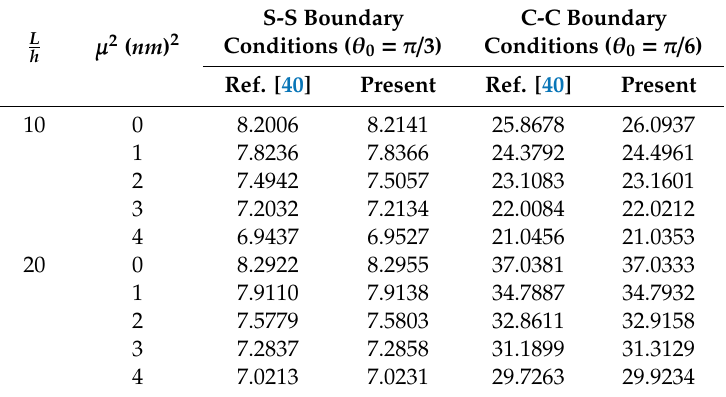
Table 3. Comparative evaluation between the proposed formulation and predictions from a previous study [57], in terms of first natural frequency for varying L / h ratios, nonlocal parameter µ , and boundary